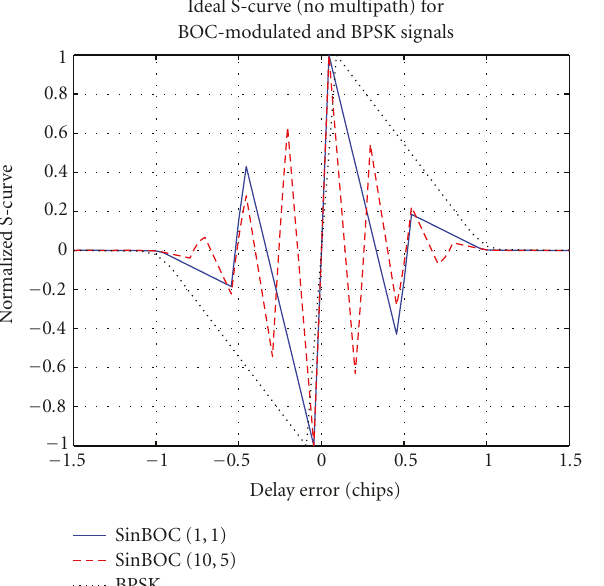
Figure 4: Ideal S-curves for BOC-modulated and BPSK signals (NEML, Δ = 0 . 1 chips).